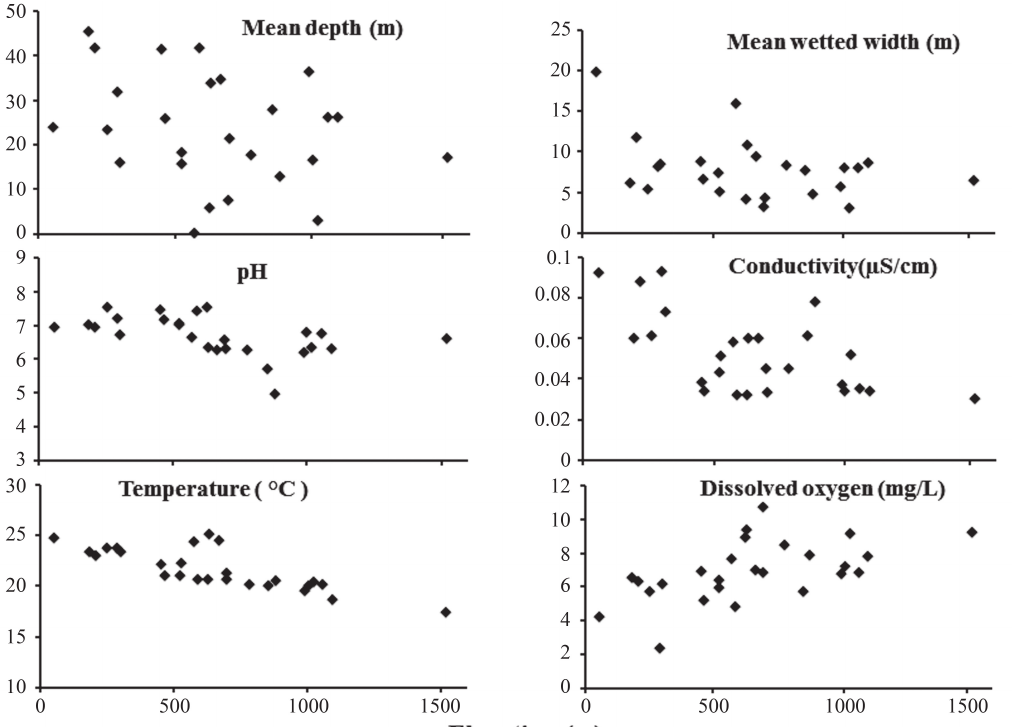
Fig. 3 . Changes in physicochemical parameters of streams along an elevation gradient in Cusuco National Park, Honduras in summer 2013.